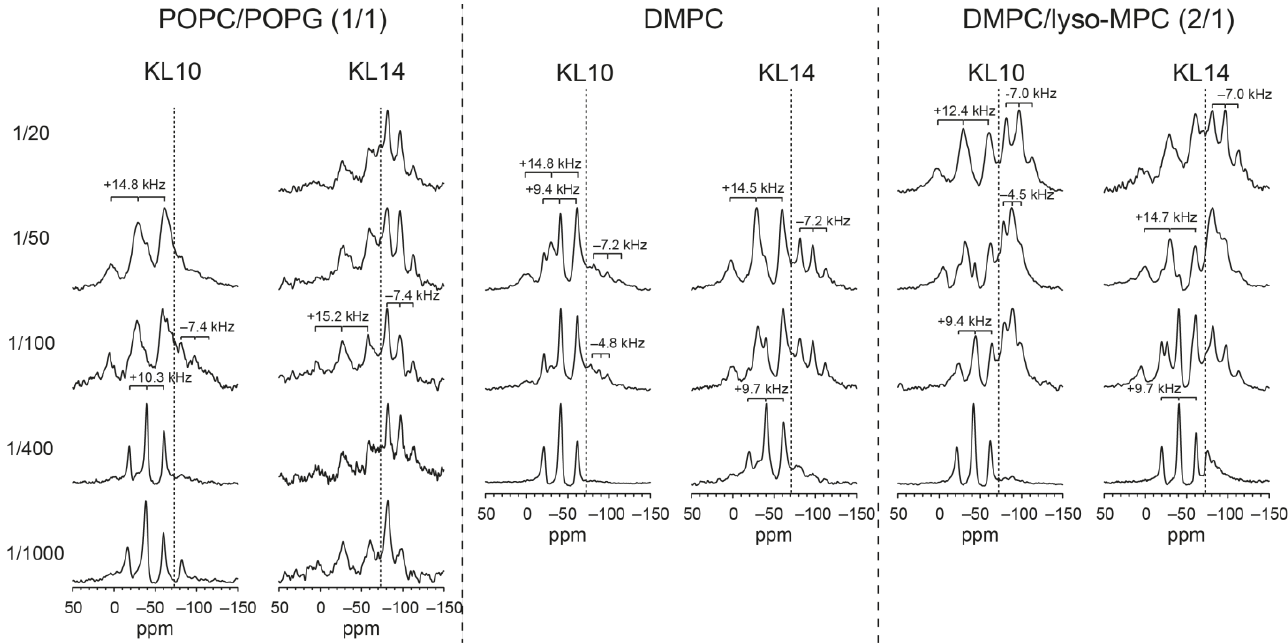
Figure 6. Solid-state 19 F-NMR spectra of KL10- 19 F and KL14- 19 F (labeled with a single CF 3 -group at position 6) in macroscopically oriented membrane samples aligned as above. Dotted lines indicate the isotropic chemical shift (−72 ppm). Triplets arise from the dipolar coupling between the 19 F nuclei within the CF 3 -group, and the splitting depends on the orientation of the C-CF 3 bond with regard to the membrane normal. Triplets to the left and right of the isotropic chemical shift have positive and negative signs of dipolar coupling, respectively. Three lipid systems were used, as denoted above each column, and several P/L ratios, as indicated on the left of each row of spectra (P/L values are for KL14, and the same peptide-to-lipid mass ratios were used for KL10).